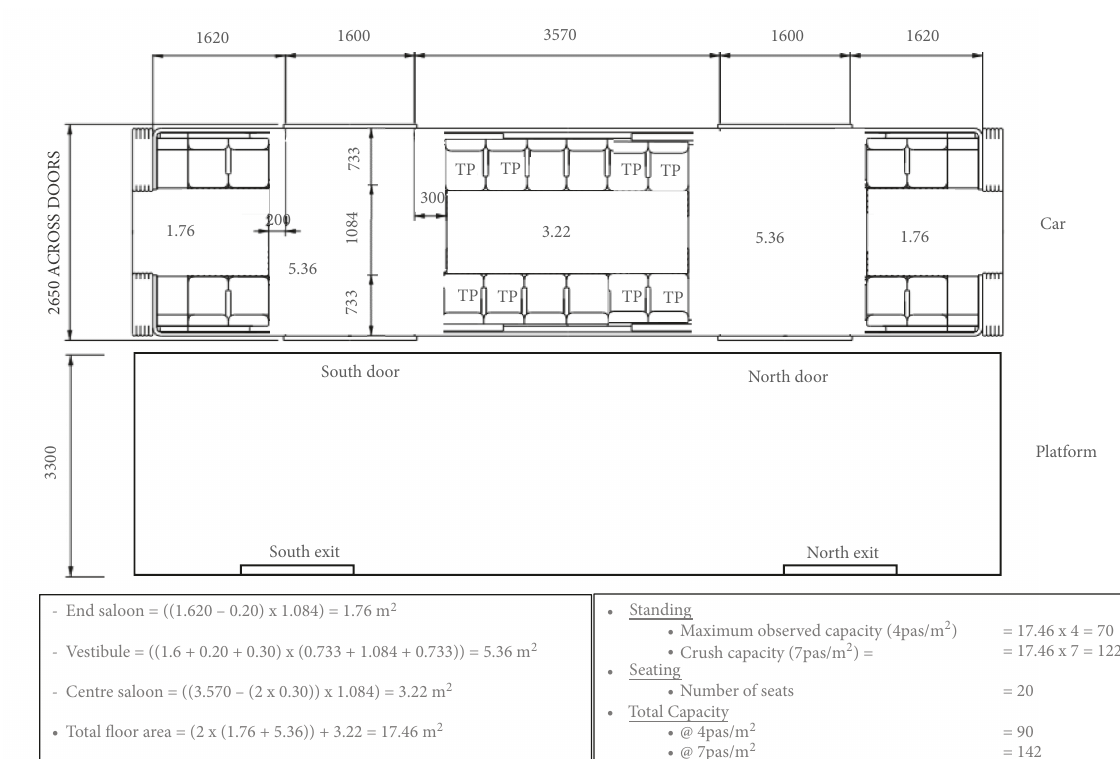
Figure 1: Drawing, dimensions (mm), and areas calculations (m 2 ) for the simulated experiments at